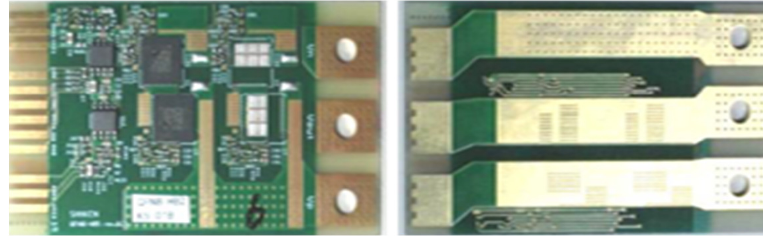
Figure 12. Prototype of the DPT with the inbuilt gate drive circuitry (provided by Sanken Inc).